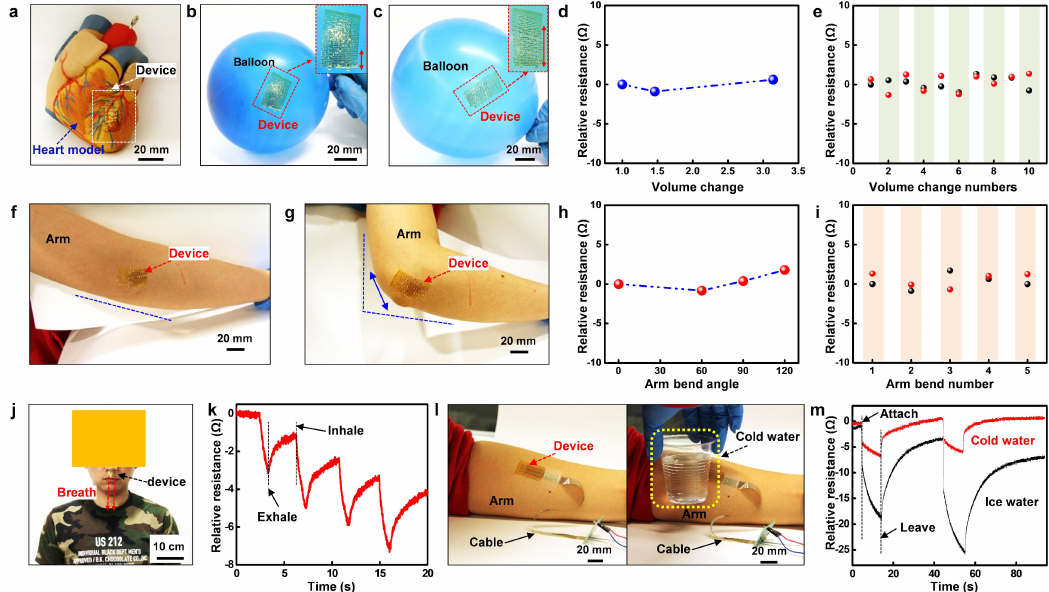
Figure 7. Applications and test: ( a ) Device attached to an artificial heart. ( b ) Device pasted on a less inflated balloon. ( c ) The inflation of the balloon, with the stretch of the device. ( d ) Resistance change of the temperature sensor with the balloon expands its volume. ( e ) Relative resistance under expansion cycles up to 10 (black dot: before expansion, red dot: after expansion). ( f ) The original state of the device pasted on the elbow. ( g ) Arm bent to 90 ◦ , with the device stretched along with the bending. ( h ) Relative resistance under di ff erent bending angles. ( i ) Relative resistance when bending up to 5 cycles (black dot: before bending, red dot: after bending). ( j ) The photograph of the device under the nose to monitor the breathing. ( k ) Time-dependent relative resistance in regarding the inhale and exhale cycles. ( l ) The device on the arm is tested with cold water. ( m ) Time-dependent response of the signal in touch with cold water (red) and ice water